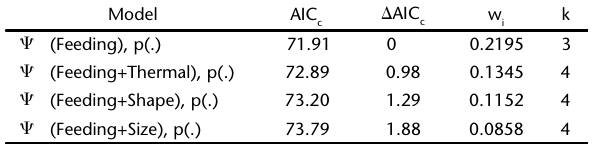
Table I. The subset of best models ( (cid:6) AIC (cid:5) 2) of vegetation remnant (VR) occupancy by communal roosts of Black Vultures ( Coragyps atratus ) in the urban area of Manaus, Central Amazon, Brazil.